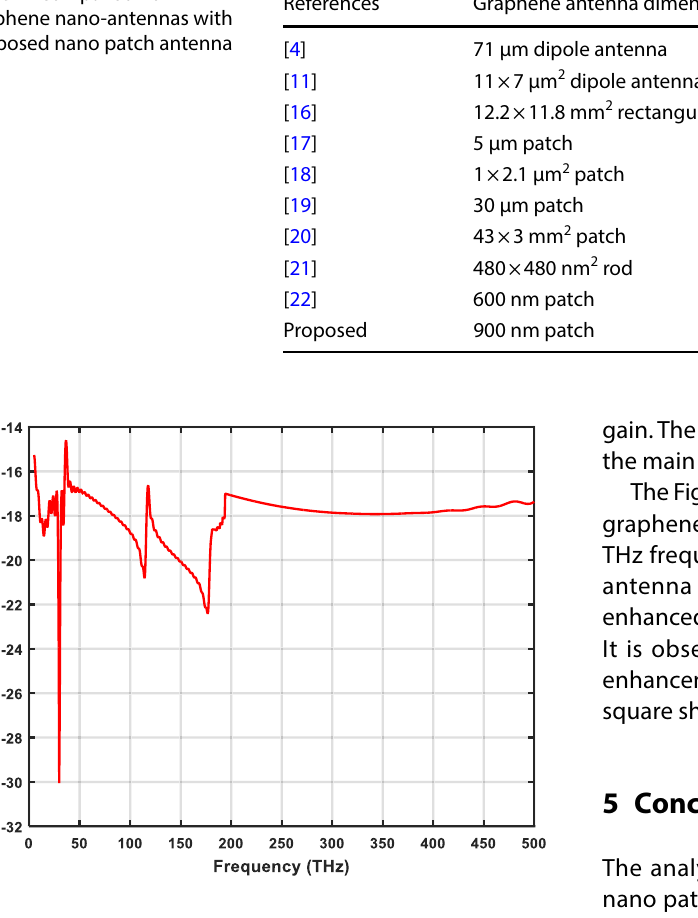
Fig. 9 S parameters of the graphene nano patch at μ 11